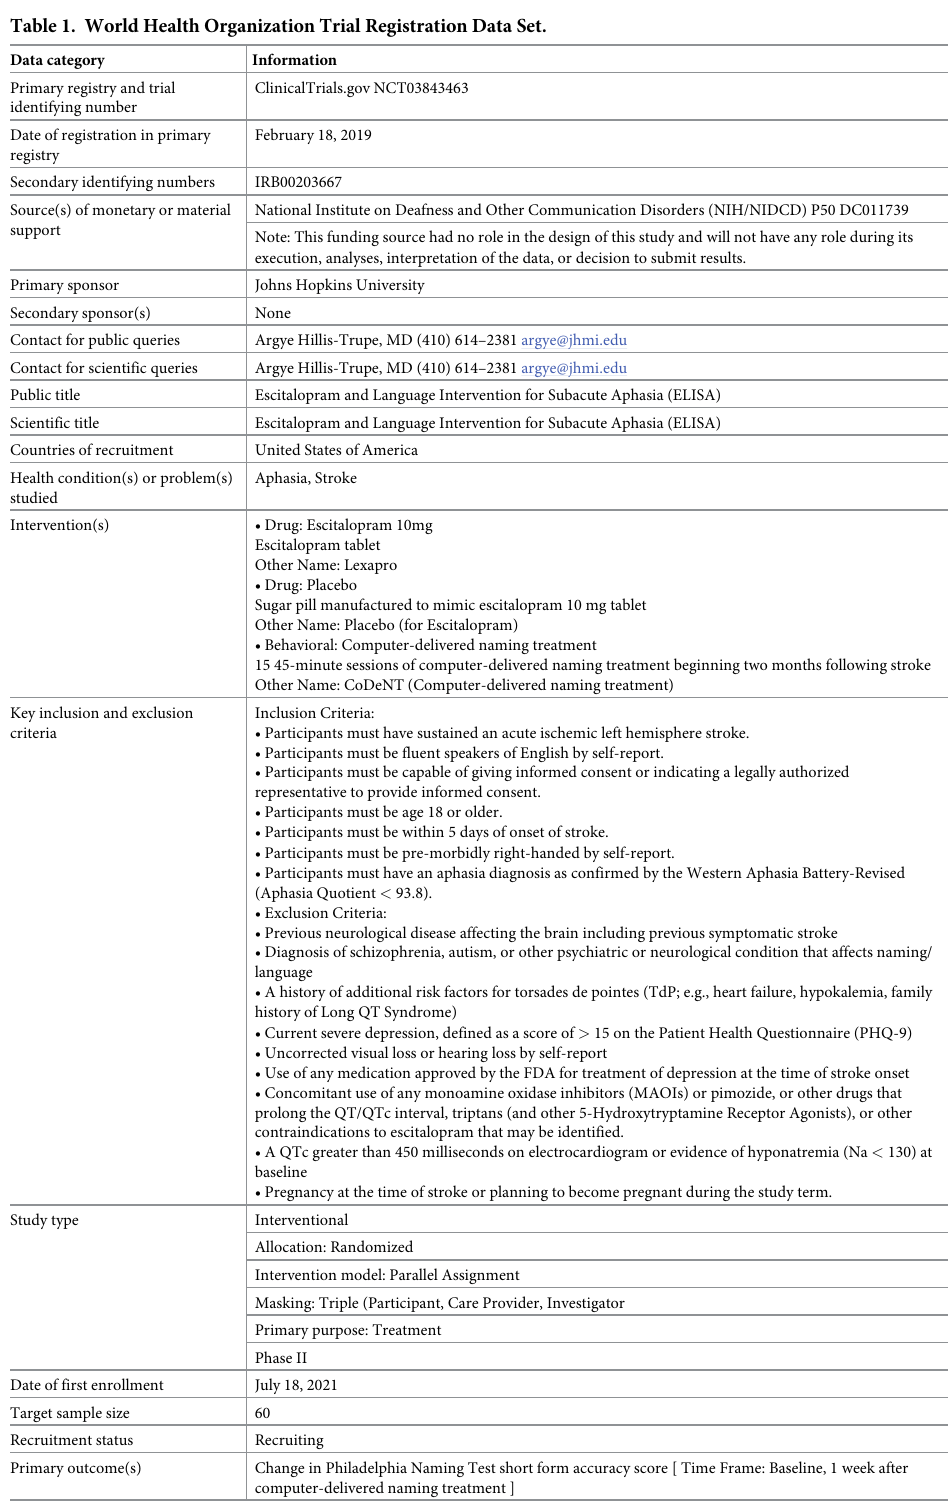
Table 1. World Health Organization Trial Registration Data